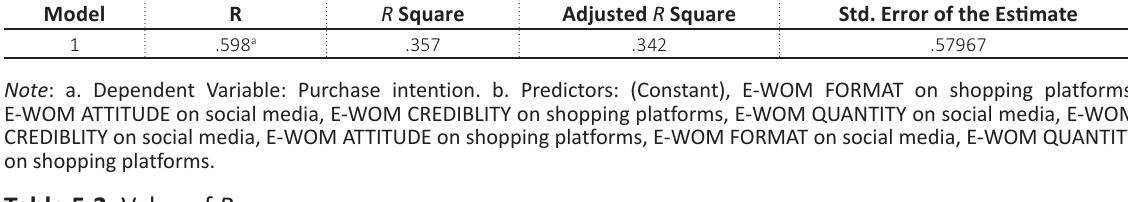
Table 5.2. Value of P